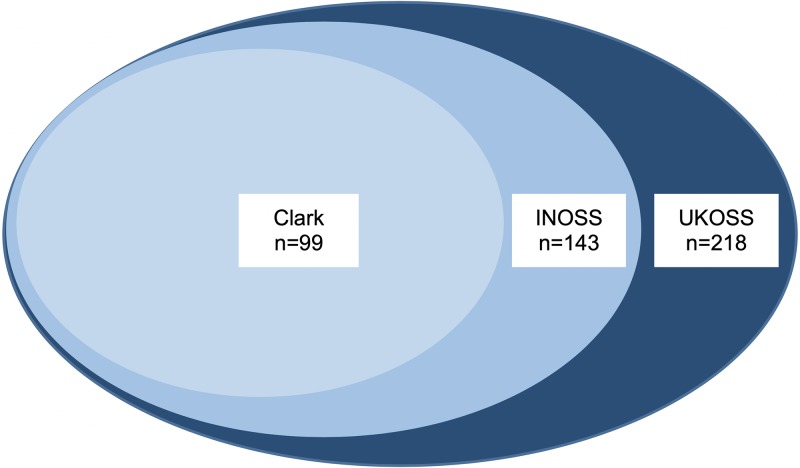
Total number of women in Australia, France, the Netherlands, Slovakia, and the UK meeting UKOSS case definition (dark blue), modified INOSS case definition (medium blue), and modified Clark case definition (light blue) of AFE.AFE, amniotic fluid embolism; INOSS, International Network of Obstetric Survey Systems; UKOSS, UK Obstetric Surveillance System.